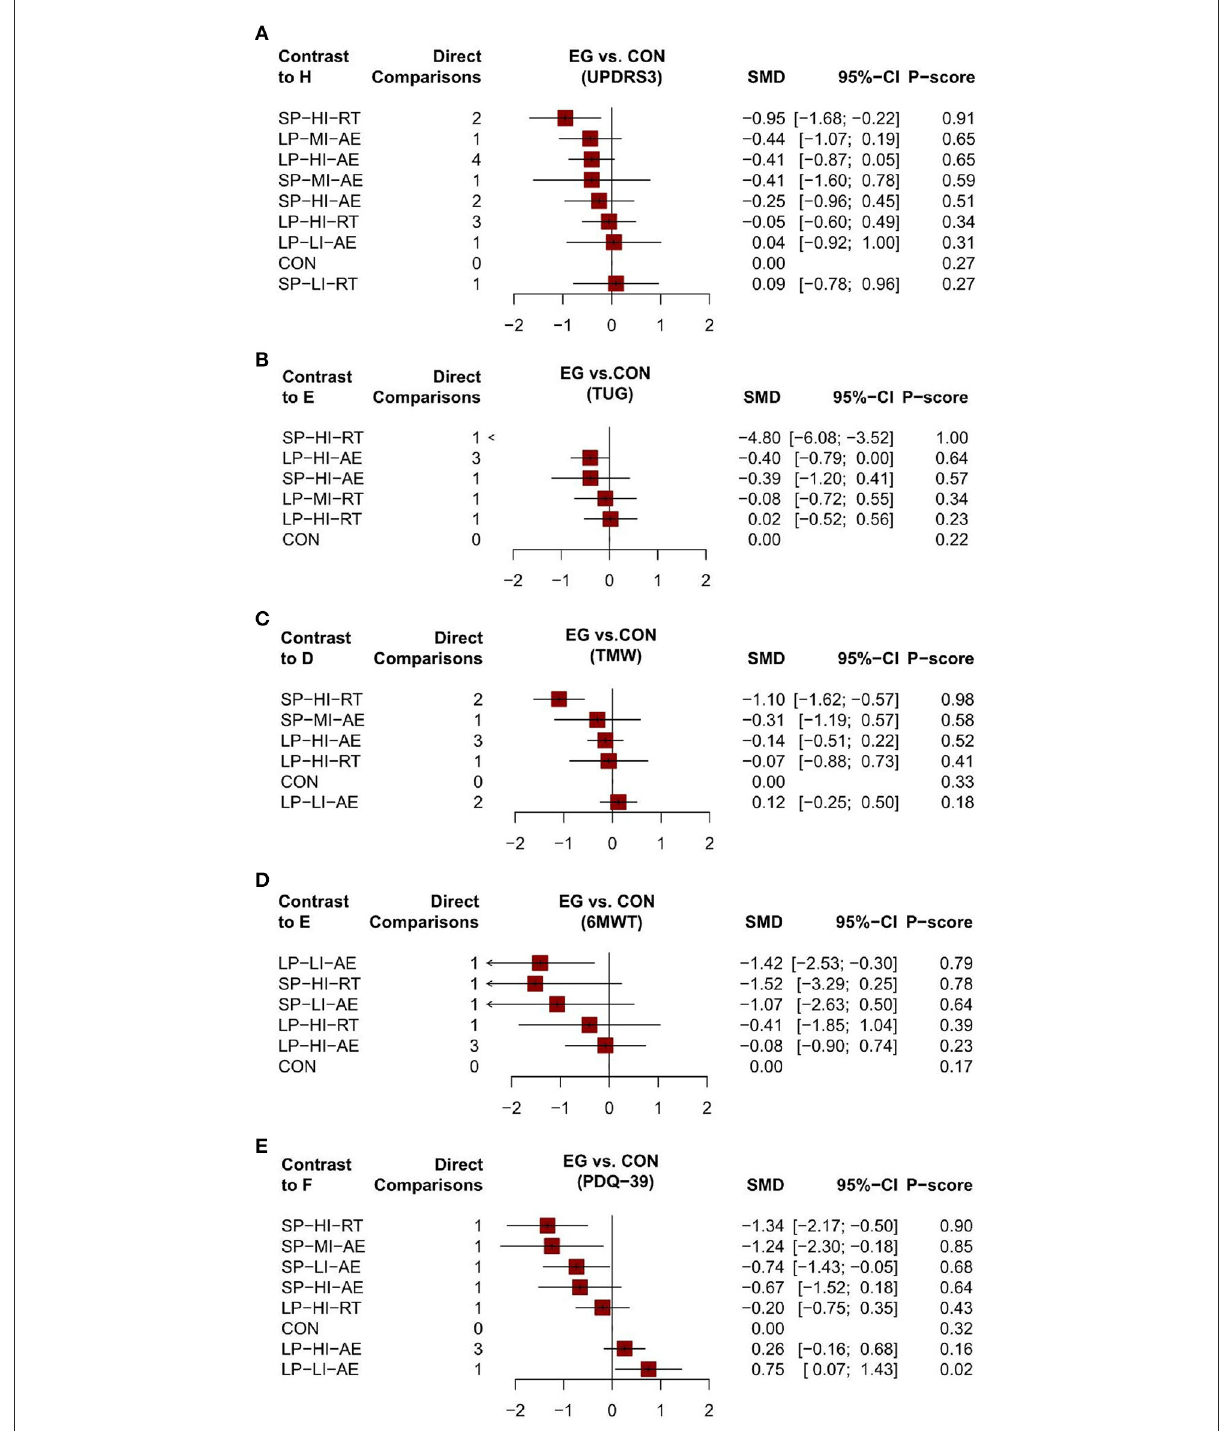
FIGURE6 The forest plot of aerobic and resistance exercise outcomes [ (A) UPDRS-III outcome; (B) TUG outcome; (C) TWM outcome; (D) 6MWT outcome; (E) PDQ-39 outcome; SP-MI-AE, short period moderate intensity aerobic exercise; SP-LI-AE, short period low intensity aerobic exercise; SP-HI-RT, short period high intensity resistance training; SP-HI-AE, short period high intensity aerobic exercise; SP-LI-RT, short period low intensity resistance training; LP-LI-AE, long period low intensity aerobic exercise; LP-HI-RT, long pe-riod high intensity resistance training; LP-HI-AE, long period high intensity aerobic exercise; LP-MI-AE, long period moderate intensity aerobic exercise; CON, control group; EG, experimental group; SMD, Mean Difference; 95%CI, confidence